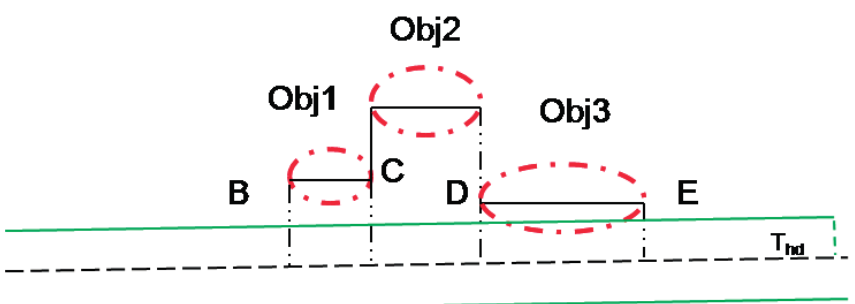
Figure 12. Cross-section of dDSM obtained by using the proposed method, where the black dash line is the zero height difference. The green solid line represents the threshold of height difference ( T hd ), below which the dDSM value is set to zero. Thereafter, Obj1, Obj2, and Obj3 are obtained using the smoothness computation and connected component analysis